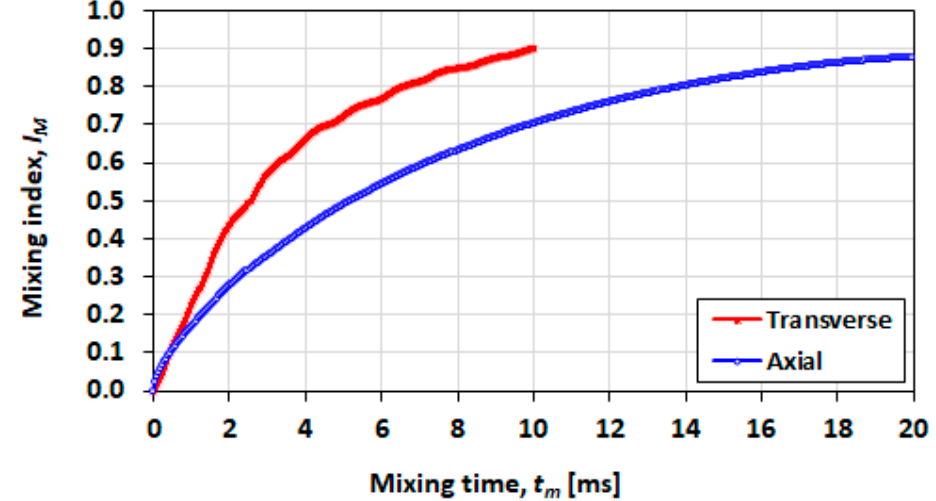
Figure 23. Effect of the initial mixing orientation on the mixing index for a droplet with initial length of L 0 = 5 h , Ca = 0.21 and λ = 0.5.